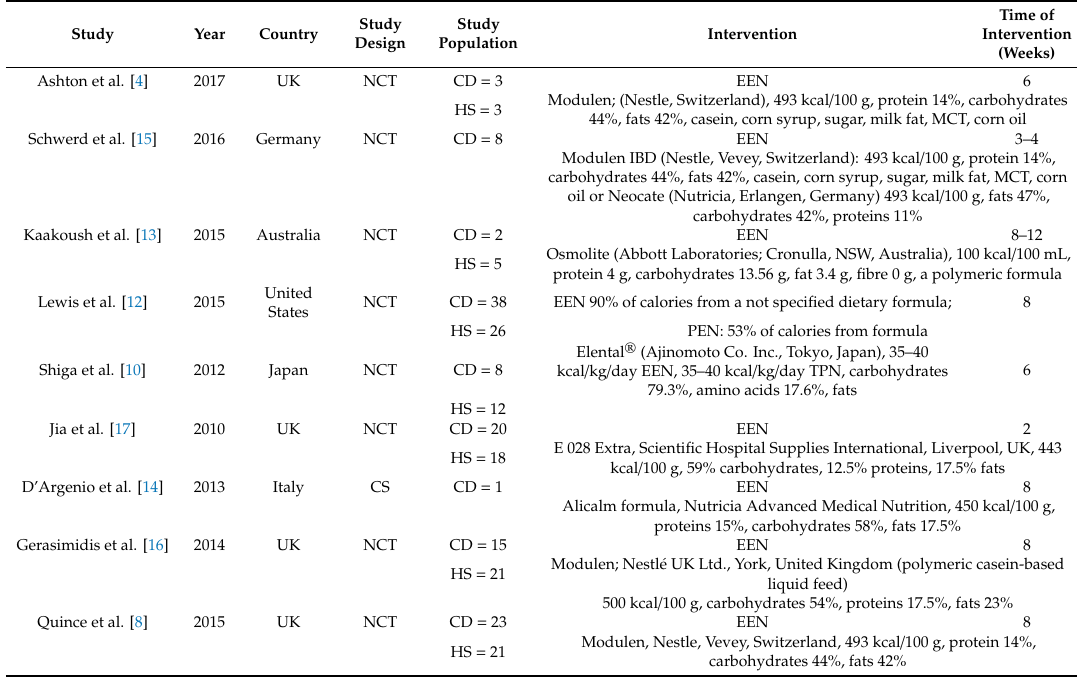
Table 1. Characteristic of included